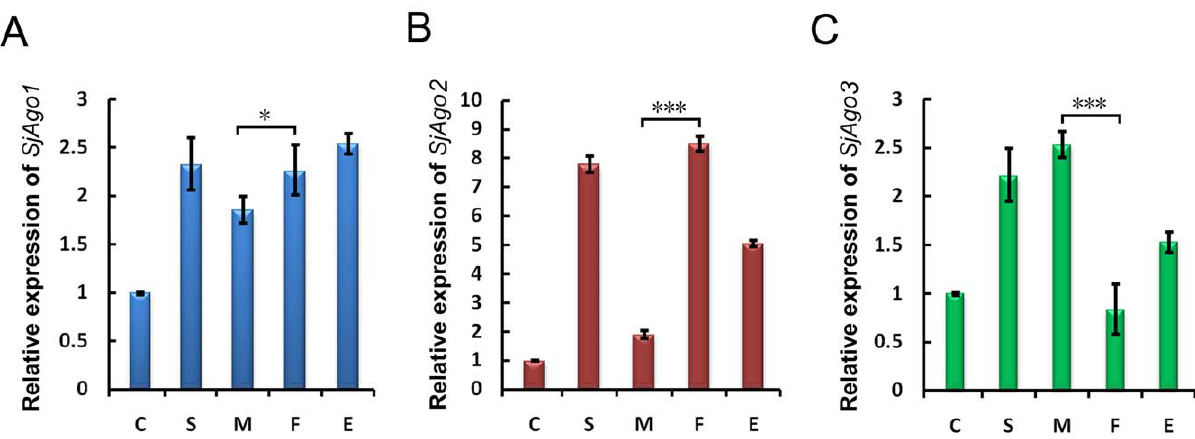
Figure 1. Trnascriptional analysis of three S.japonicum Argonaute genes. Relative levels of SjAgo1 ( A ), SjAgo2 ( B ), and SjAgo3 ( C ) transcripts at different life stages (C, cercariae; S, hepatic schistosomula; M, male adult worms; F, female adult worms; E, eggs) were detected by qRT-PCR performed with three technical replicates. Transcriptional levels were calibrated based on the comparative 2 2 DD Ct method using the housekeeping gene SjPSMD4 as an endogenous control, and normalized to the expression in the cercarial stage. Error bars represent the standard deviations of the mean from the three technical replicates. The Student’s t -test was employed to analyze the differential expression of SjAgos between male and female adult worms. *, p , 0.05; ***, p , 0.001. Here only the significance in difference between male and female parasite is